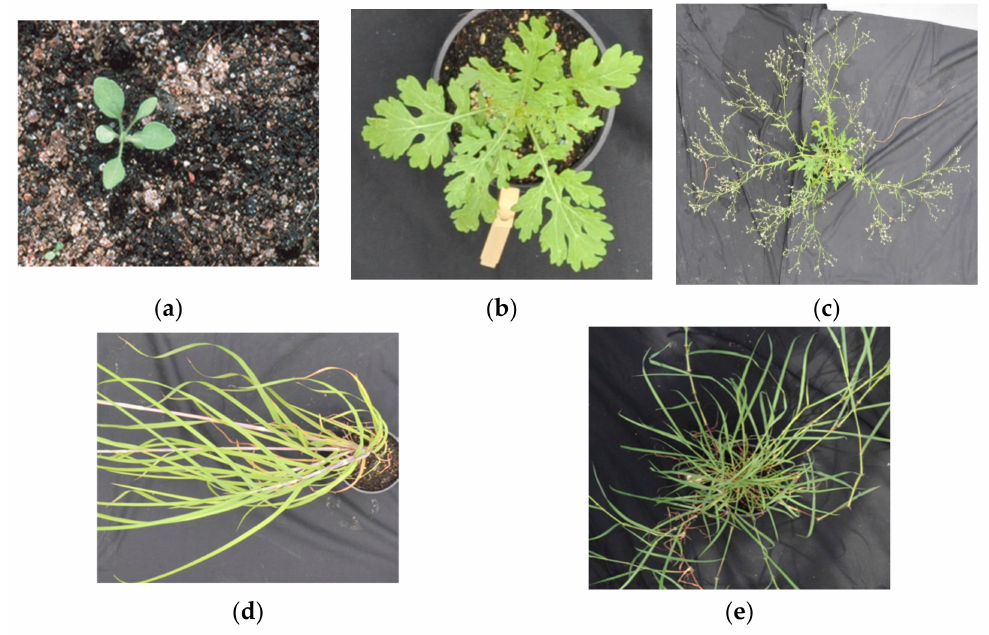
Figure 1. Aerial photos of the three parthenium weed growth stages of ( a ) seedling, ( b ) rosette, ( c ) flowering adult plant, and co-occurring monocot plants of ( d ) desert bluegrass ( Bothriochloa ewartiana ) and ( e ) kangaroo grass ( Themeda triandra